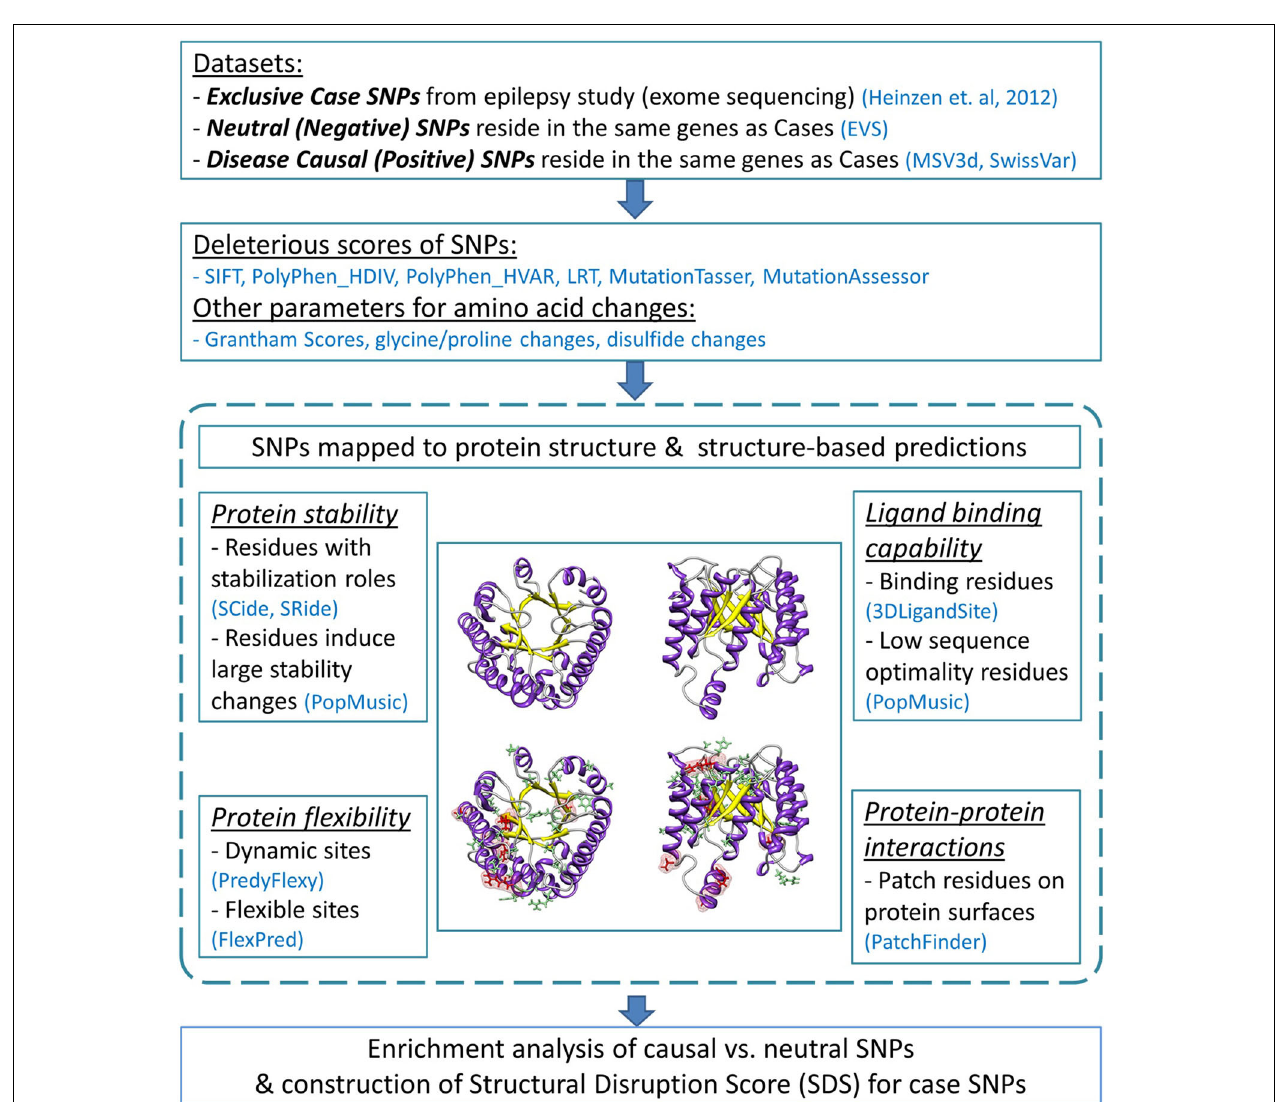
FIGURE 1 | Flow diagram of the analysis pipeline. The analysis employed sequence-based deleterious prediction scores, parameters which reflect the nature of amino acid changes, and 3D structure-based evaluations. Structural analyses were performed by characterizing functionality of mutated protein residues caused by negative and positive SNPs (indicated by green and red